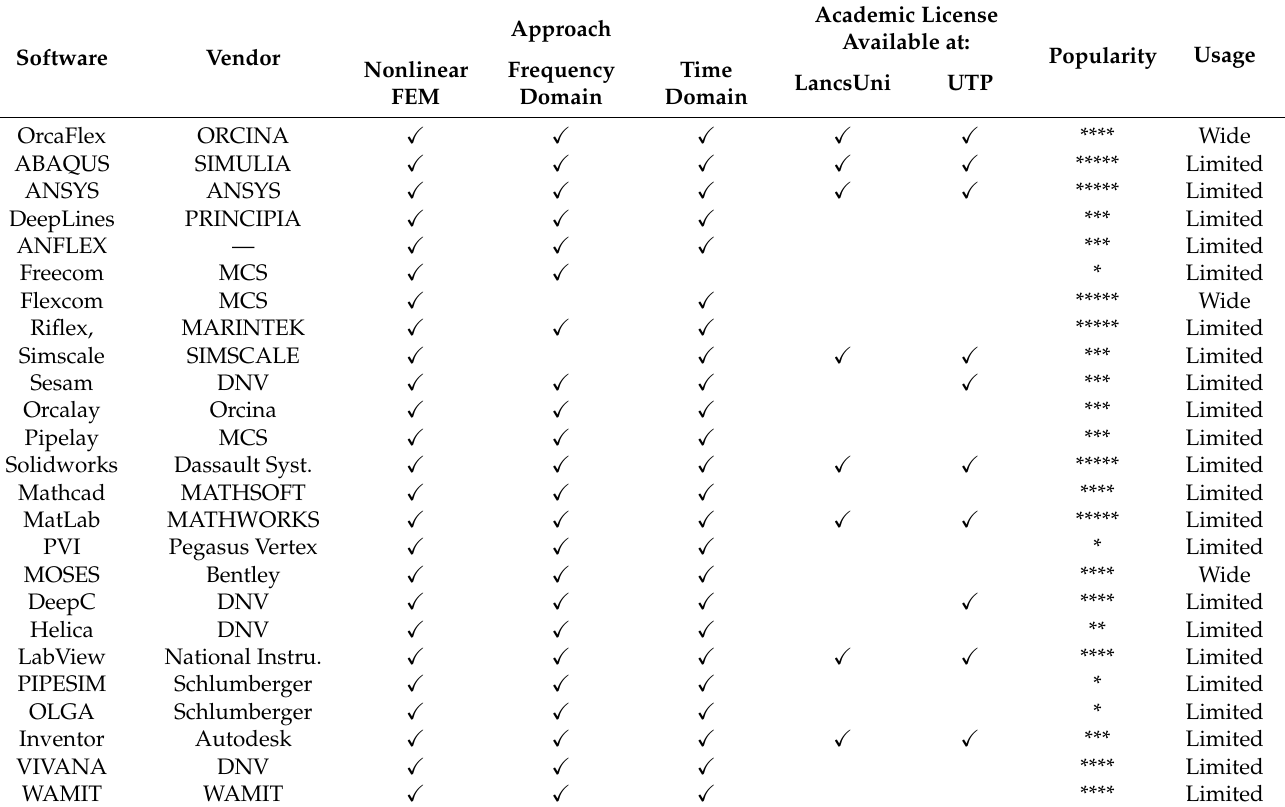
Table 2. Analysis Software for Marine Riser and related ocean engineering facilities .